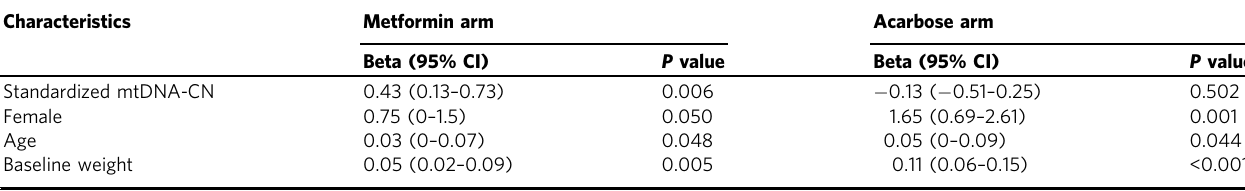
Table 2 Multiple linear association analysis between mtDNA-CN and weight loss at week 24.